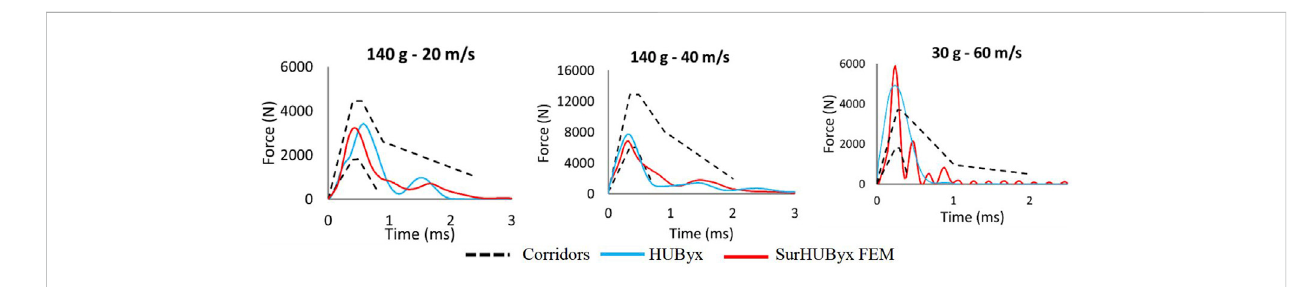
FIGURE 6 Force time curves for the three impact cases of Bir impacts.